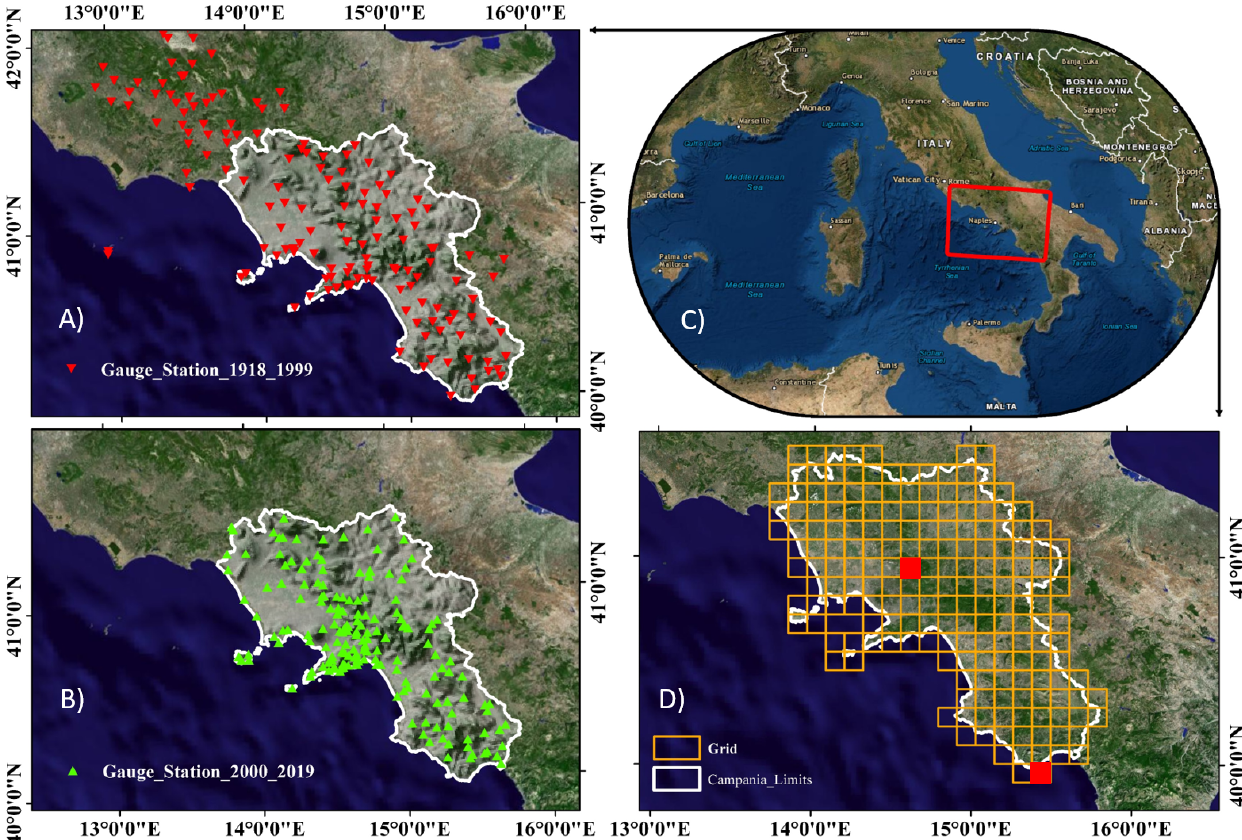
Figure 1. The studied area. (a, b) The two rain gauge networks. (c) The study area in the red box. (d) The grid shape for the region under investigation. Red boxes represent grid cells no. 2 and no. 108 reported in Fig.